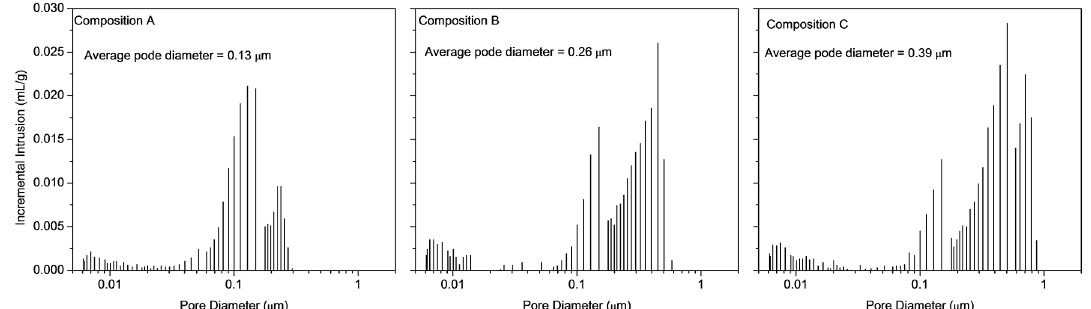
Figure 3. Pore size distributions obtained by Hg intrusion porosimetry